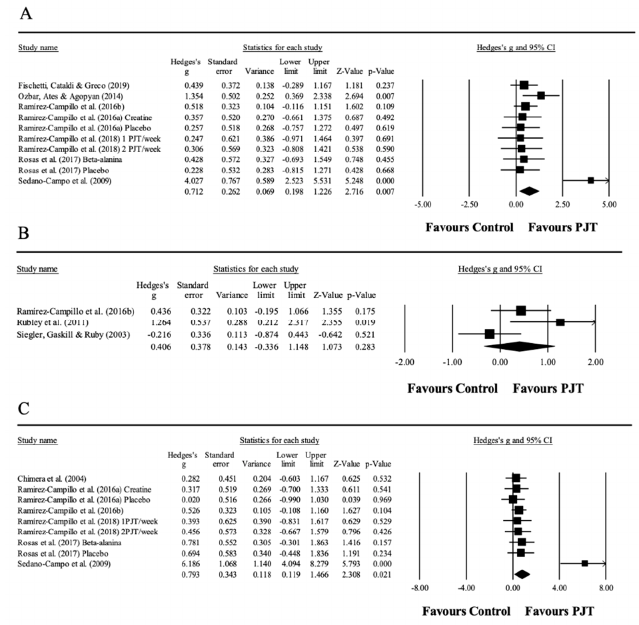
Figure 2. Forest plot of changes in countermovement jump ( A ), countermovement jump with arms awing ( B ), and drop jump performance ( C ) in athletes participating in plyometric jump training (PJT) compared to controls. Values shown are effect sizes (Hedges’s g) with 95% confidence intervals (CI). The size of the plotted squares reflects the statistical weight of the study.